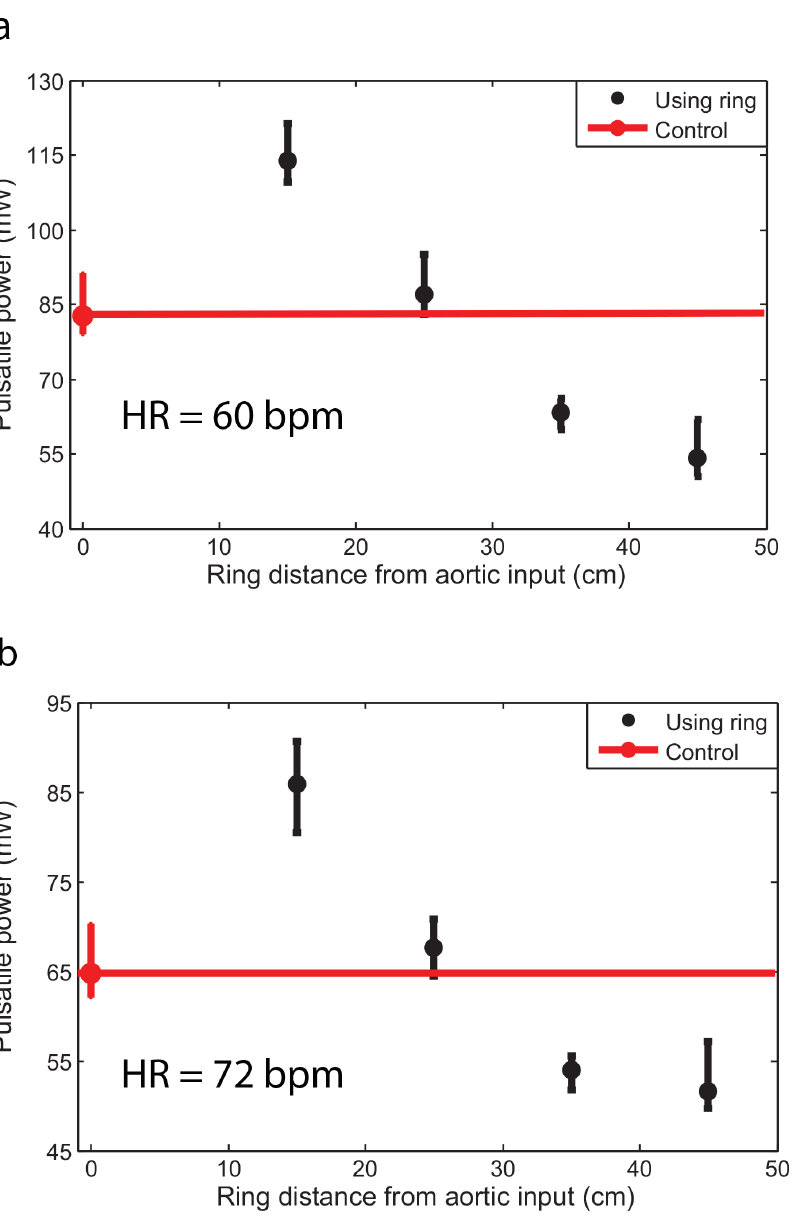
Figure 8. The effect of an extra reflection site created by a ring on input pulsatile power (see Materials and Methods section). (a) Results are for Aorta 3 (see Table 2) with PWV=9.5 m/s and HR=60 bpm . (b) Results are for Aorta 3 with PWV=9.5 m/s and HR=72 bpm . The control case is the aorta without an extra reflection site and the red line is the pulsatile power of the aorta without any rings (i.e. no extra reflection sites). The pulsatile power can increase or decrease compared to the control case (control is the aorta without the ring), the nature of which depends on the location of the ring. Each data point is the result of the respective experiment repeated nine times.